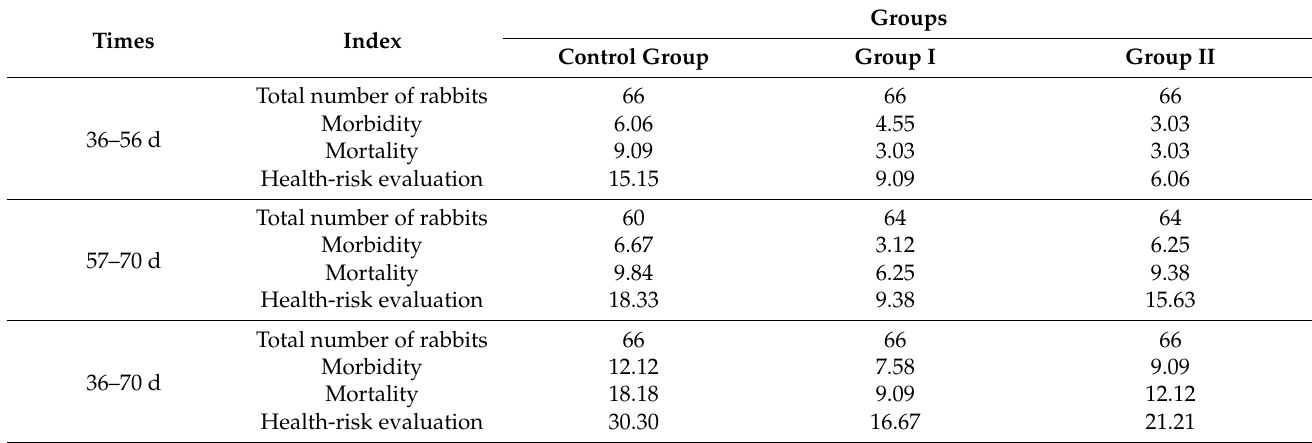
Table 4. Effects of feed restriction and compensation on health status of rabbits